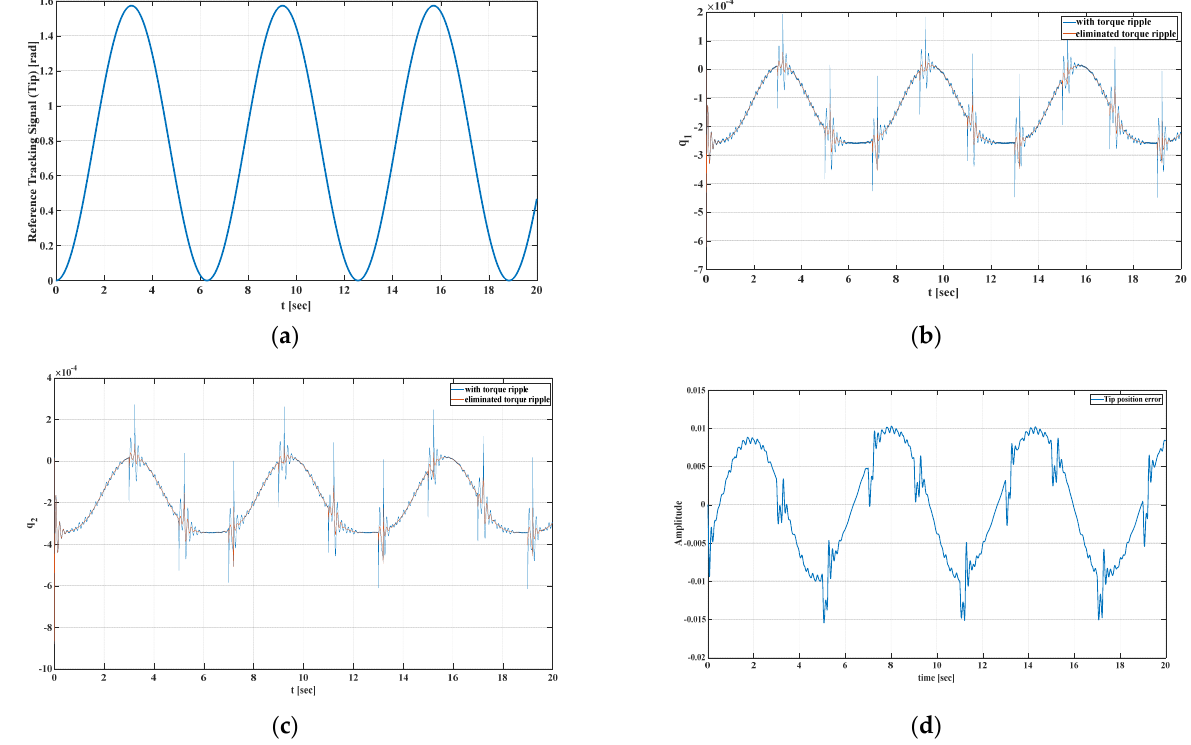
Figure 5. A sinusoidal reference signal for tracking control ( a ). Set-point ( b , c ) and tracking ( d ) control performance of the SMC-based adaptive linearizing control scheme concerning the sinusoidal type endpoint reference (the units are in radian).